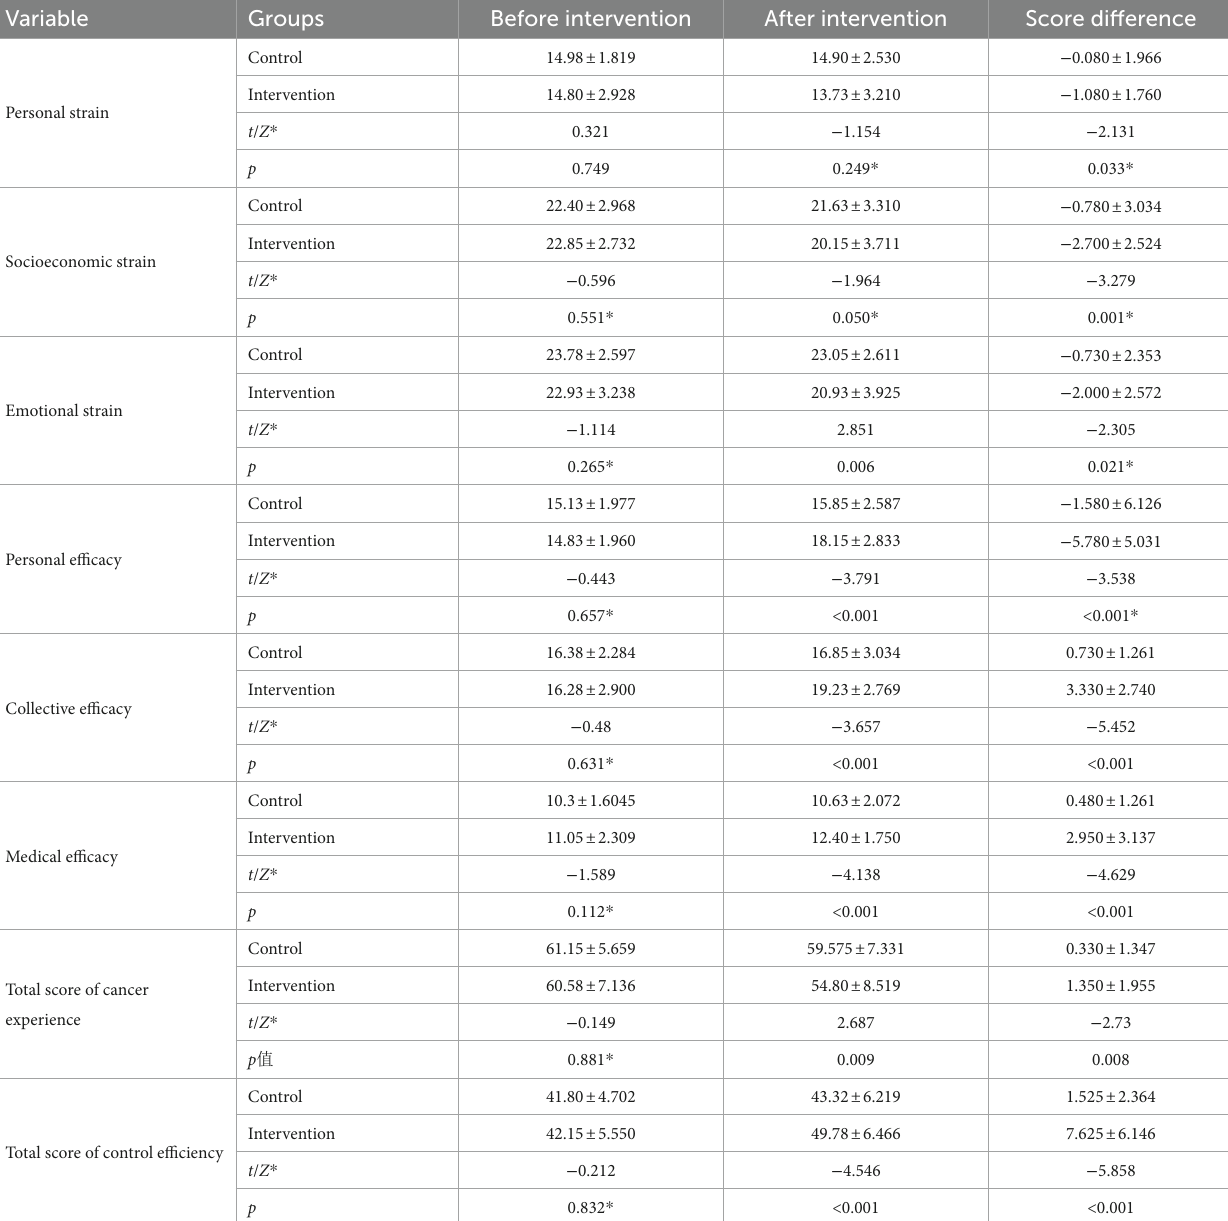
TABLE 2 Comparison of perceived control scores of breast cancer patients in different groups before and after intervention ( n = 80).